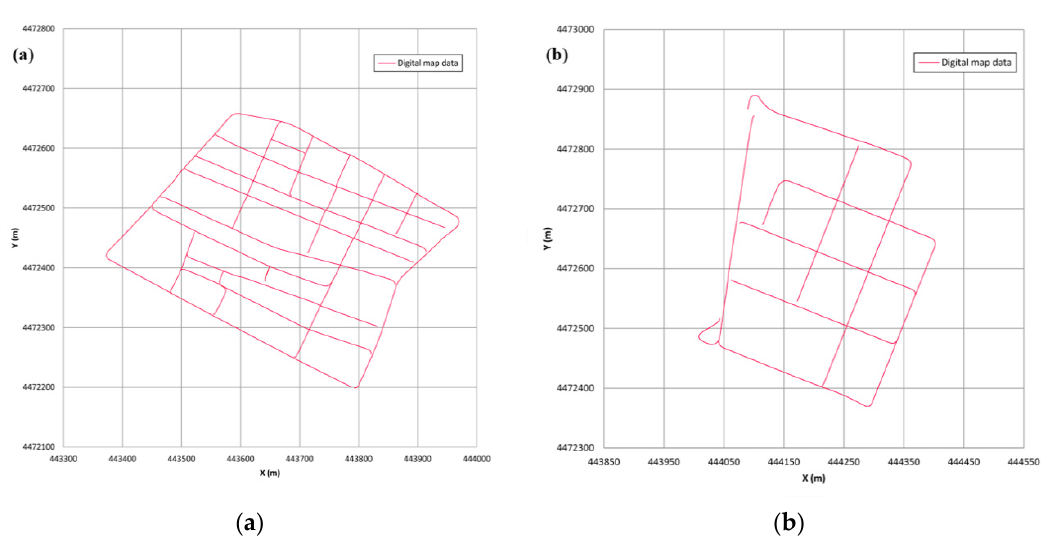
Figure 4. Digital maps for the test areas. ( a ) Route 1, ( b ) Route 2.